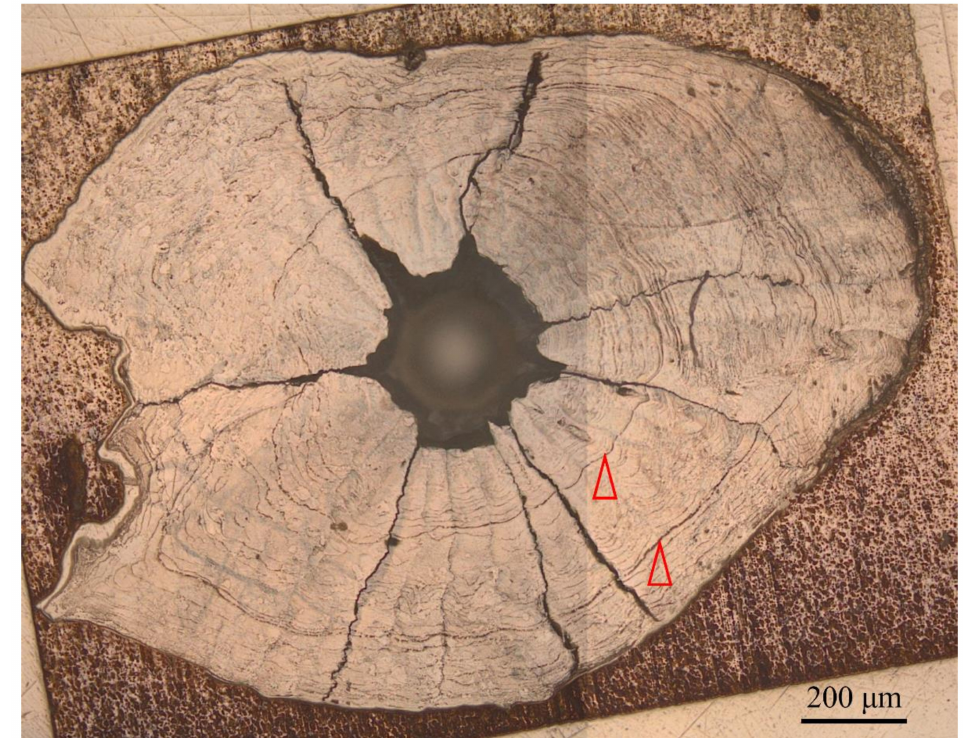
Figure 2. Otolith after drilling of the nucleus region. The red triangles show the